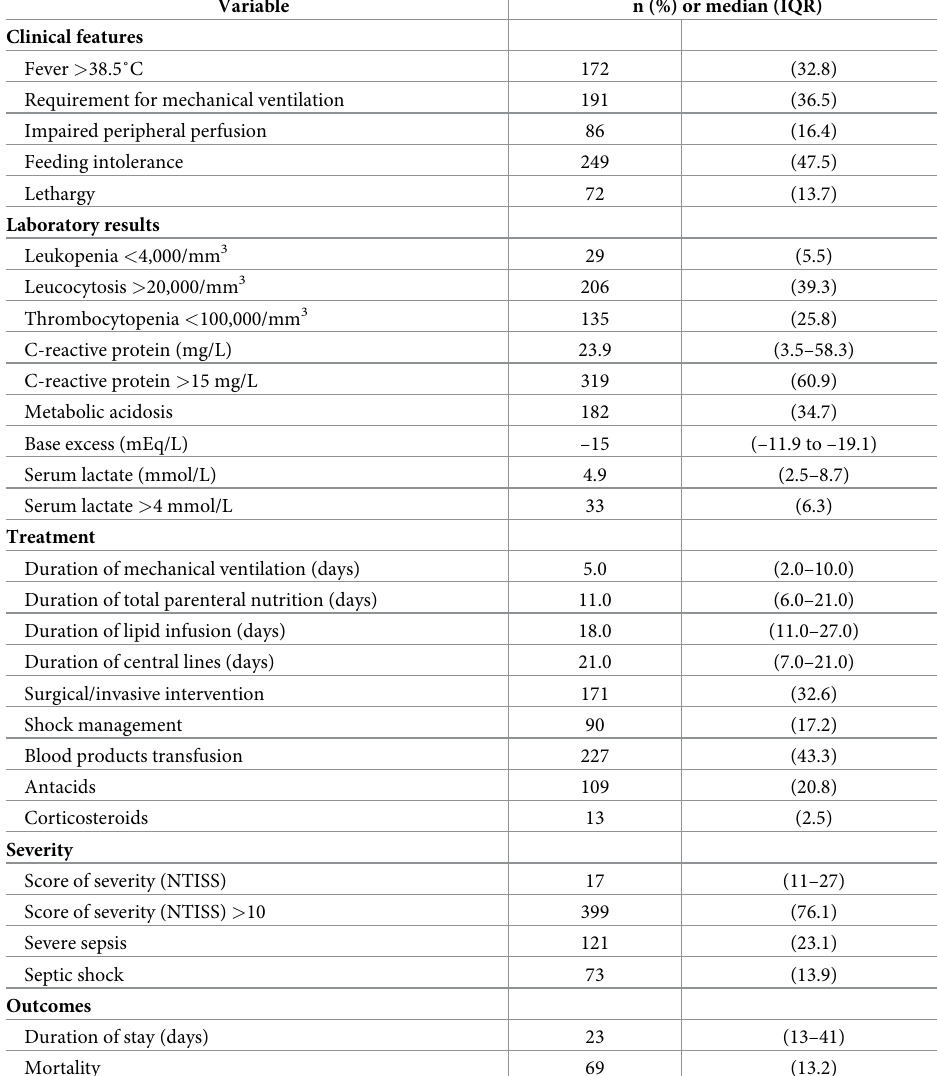
Table 2. Key clinical observations of 524 patients recruited with neonatal